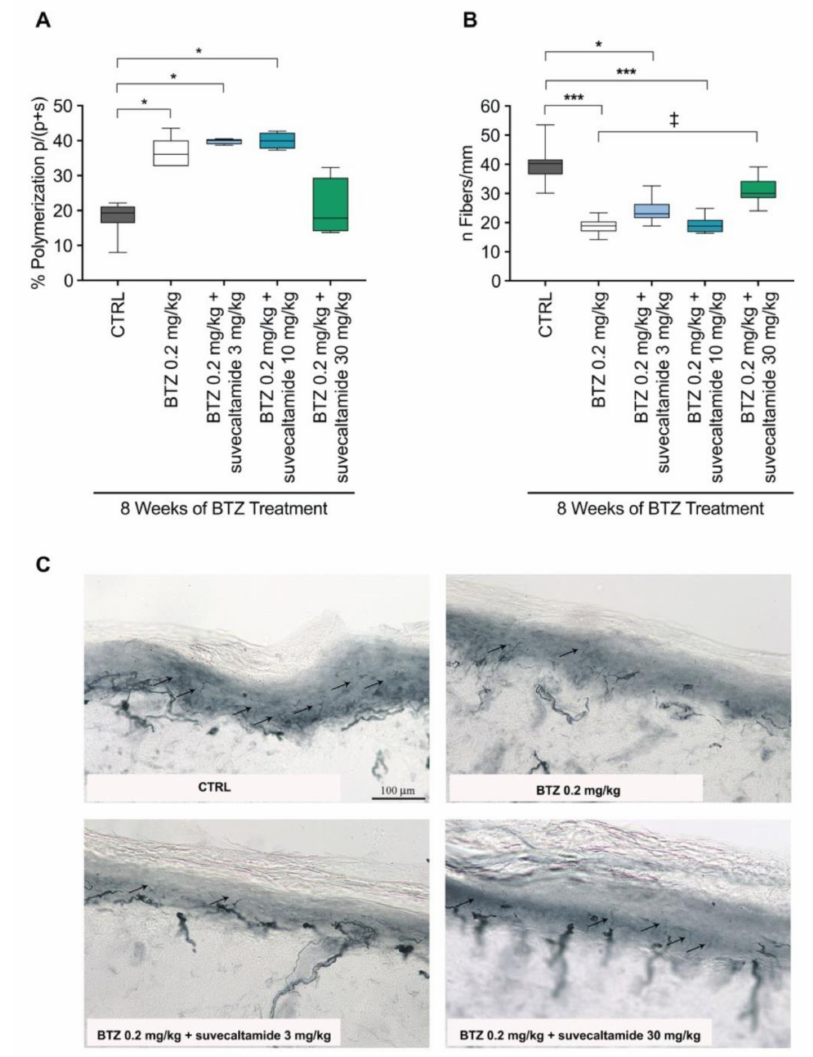
Figure 4. β -Tubulin polymerization, intraepidermal nerve fiber density (IENF), and histopathology. ( A ) Percent of β -tubulin polymerization in protein extracts from sciatic nerve tissue collected after 8 weeks of treatment with BTZ in the presence or absence of suvecaltamide. ( B ) Number of nerve fibers per mm quantified in sections of plantar glabrous skin from hind paws collected after 8 weeks of treatment with BTZ in the presence or absence of suvecaltamide. ( C ) Representative images of tissue samples quantified in panel B. BTZ—bortezomib; CTRL—untreated animals. * p < 0.05 vs. CTRL; *** p < 0.001 vs. CTRL; ‡ P < 0.05 vs.